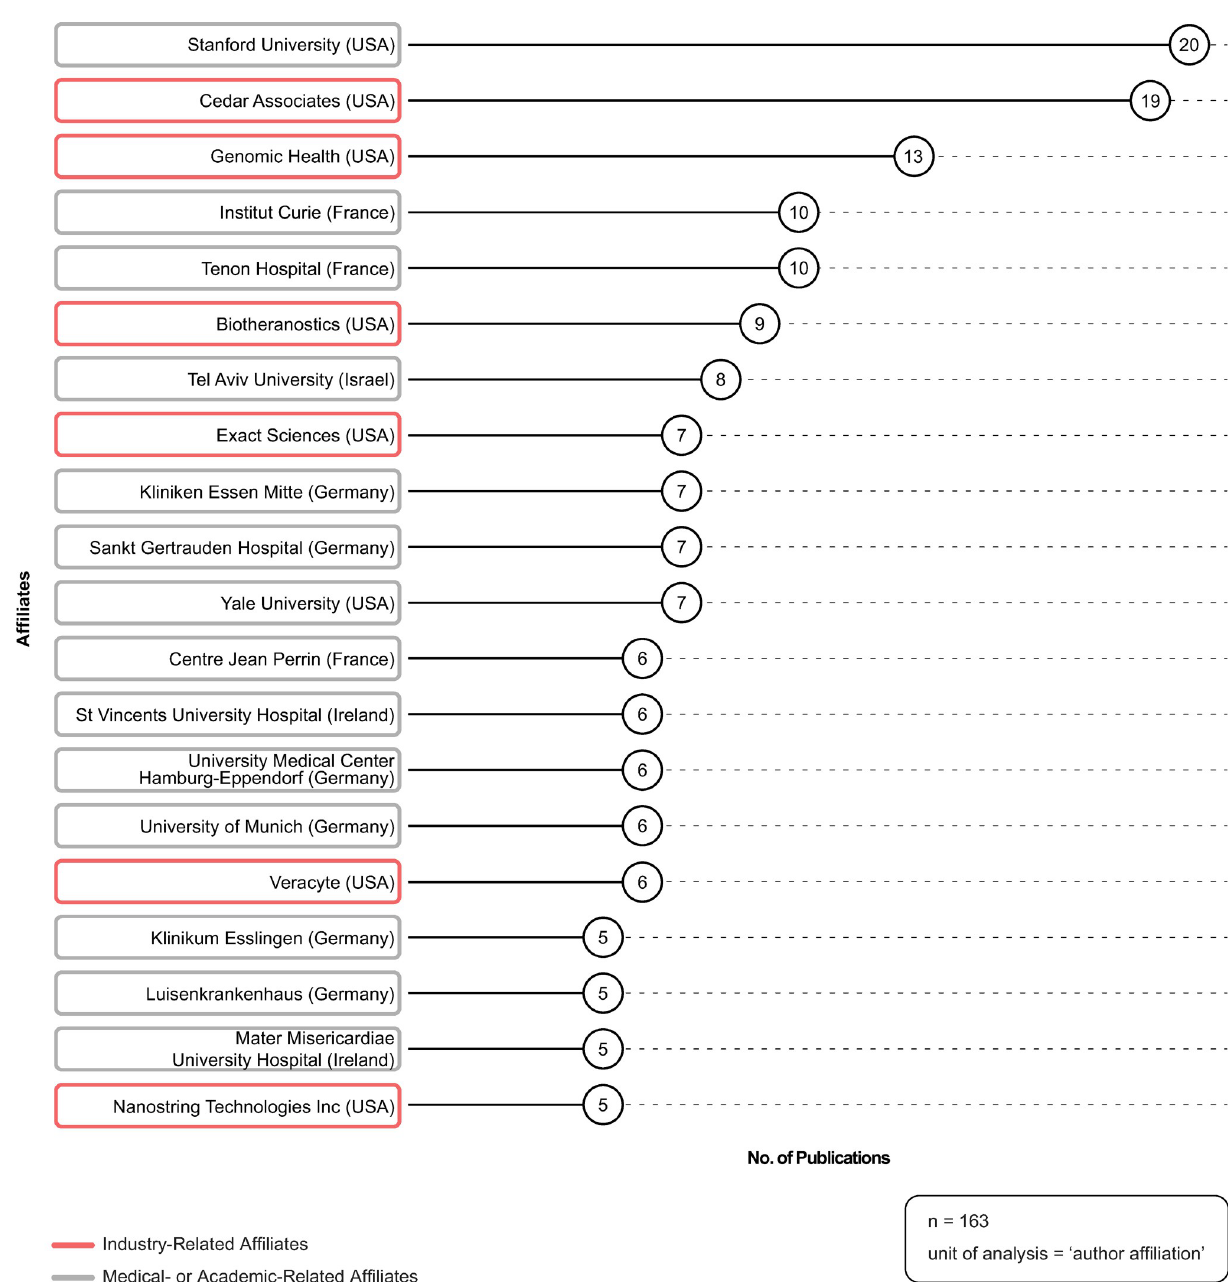
Fig 5. Top 20 affiliates. Source: R-based application Biblioshiny was used; additional analysis (i.e., affiliate-type, industry- versus medical- or academic- related) was completed by the study authors and applied to the visualization using Adobe Illustrator. Parameters specified: affiliation name disambiguation = no; number of affiliations =